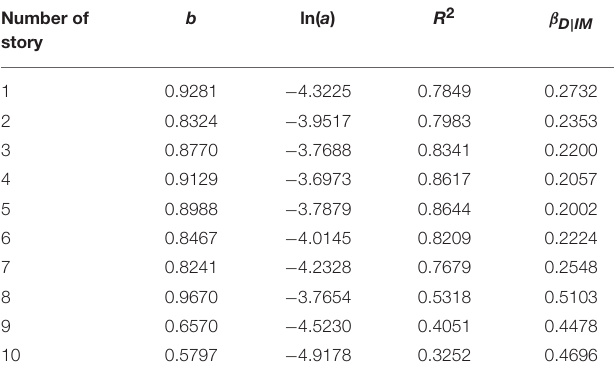
TABLE 3 | Parameters of the probabilistic seismic demand model.